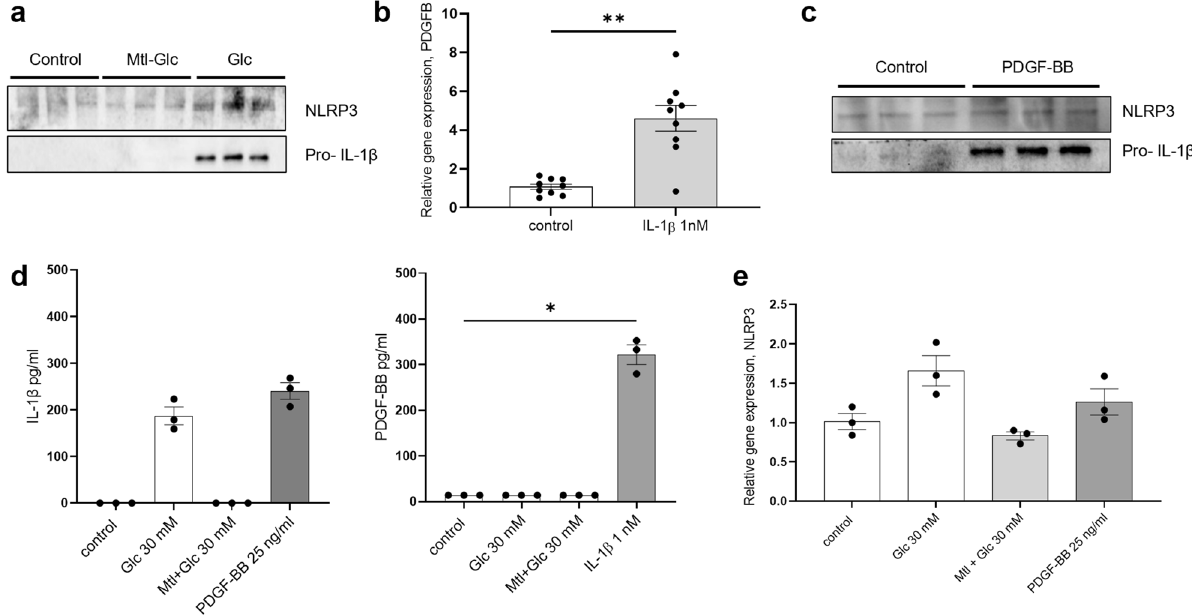
Figure 1. High glucose priming of IL-1β, stimulation of IL-1β on PDGF-BB production, and vice-versa. ( a ) Activation of the inflammasome NLRP3 and subsequent increase of pro-IL-1β protein levels were measured after 24 h stimulation of mesangial cells with Glc 30 mM. Osmotic control was Glc plus mannitol (Mtl), final concentration 30 mM. ( b ) 24 h stimulation of human mesangial cells with IL-1β 1 nM increased the levels of PDGFB mRNA. ( c ) In turn, a 24 h stimulation of mesangial cells with 25 ng/ml of PDGF-BB activated NLRP3 activity and increased pro-IL-1β protein levels. ( d ) Bio-Plex analysis of IL-1β, and PDGF-BB in media after high glucose, osmotic control, IL-1β and PDGF-BB 48 h stimulations. * P < 0.05. Data are reported as mean ± SEM. Samples under the LOD were considered equal to the lowest value in the measurable range (0.25 pg/ml for IL-1β and 13.96 pg/ml for PDGF-BB). ( e ) NLRP3 gene expression levels increased after 24 h stimulation with Glc 30 mM and PDGF-BB 25 ng/ml. Uncropped blots after chemiluminescence development and total protein stain free blots are presented in Supplementary Fig. S4a. Quantification of the bands in the western blot is reported in Supplementary Fig.